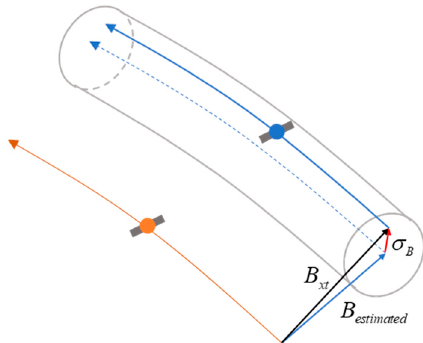
Figure 2. Baseline inclination error of Large Baseline Imaging Radar Altimeter (LB-IRA) introduced by baseline length error.